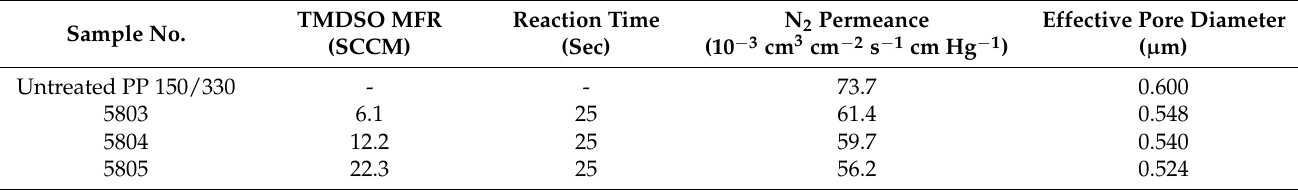
Table 4. Effect of monomer flow rate on membrane N 2 permeance (PP150/330). Sample